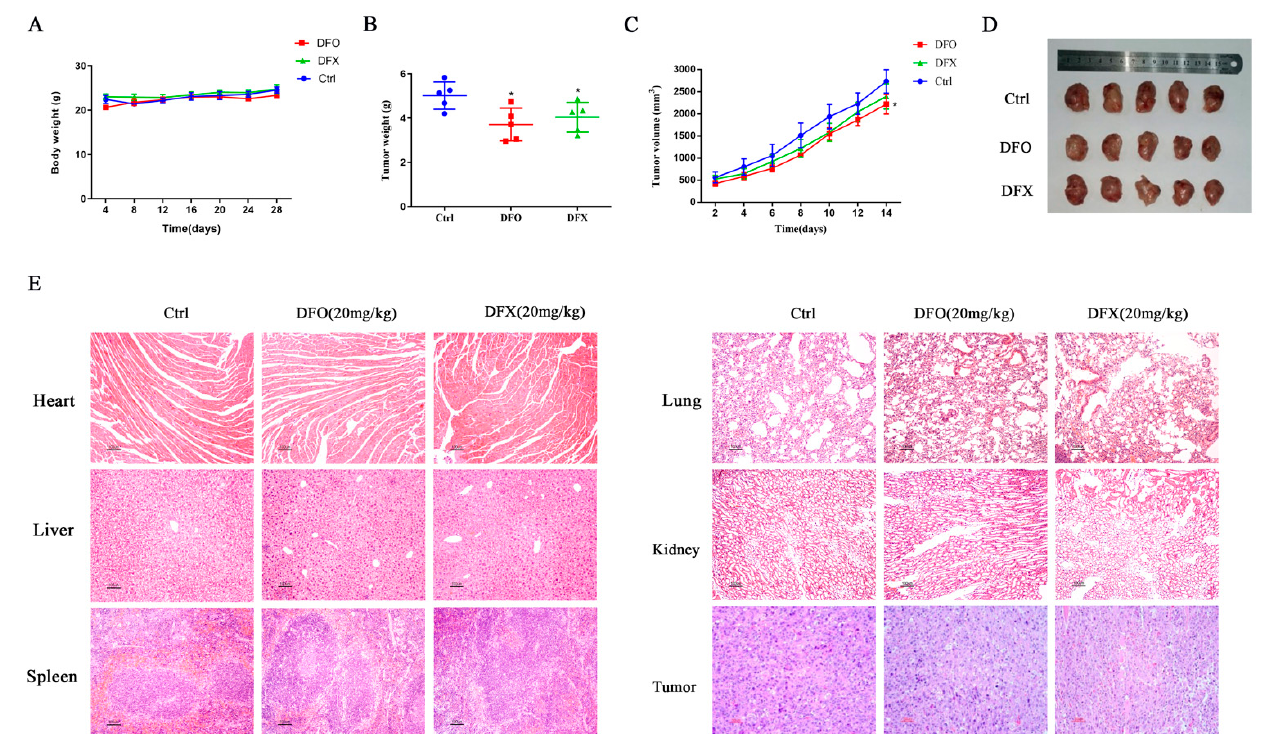
Figure 7. Iron chelators inhibited the growth of osteosarcoma in vivo. K7M2 cells were injected in situ into the bone marrow cavity of the right tibia of male BALB/c mice. Nine days after the establishment of the osteosarcoma xenotransplantation mouse model, the mice were randomly divided into 3 groups and were given normal saline and 20 mg/kg DFO or DFX once a day for two consecutive weeks. ( A ) Body weight changes in all groups. ( B ) The weights of the 3 groups of tumor tissues. ( C ) Volume changes in the 3 groups of tumor tissues. The data were calculated by the following formula: volume = length × width 2 × 1/2. ( D ) The 3 groups of tumor tissues. ( E ) H&E staining analysis of heart, liver, spleen, lung, kidney and tumor tissues (200 × and 400 × ). All data are expressed as mean ± SD (n = 5). * p < 0.05 versus control group.